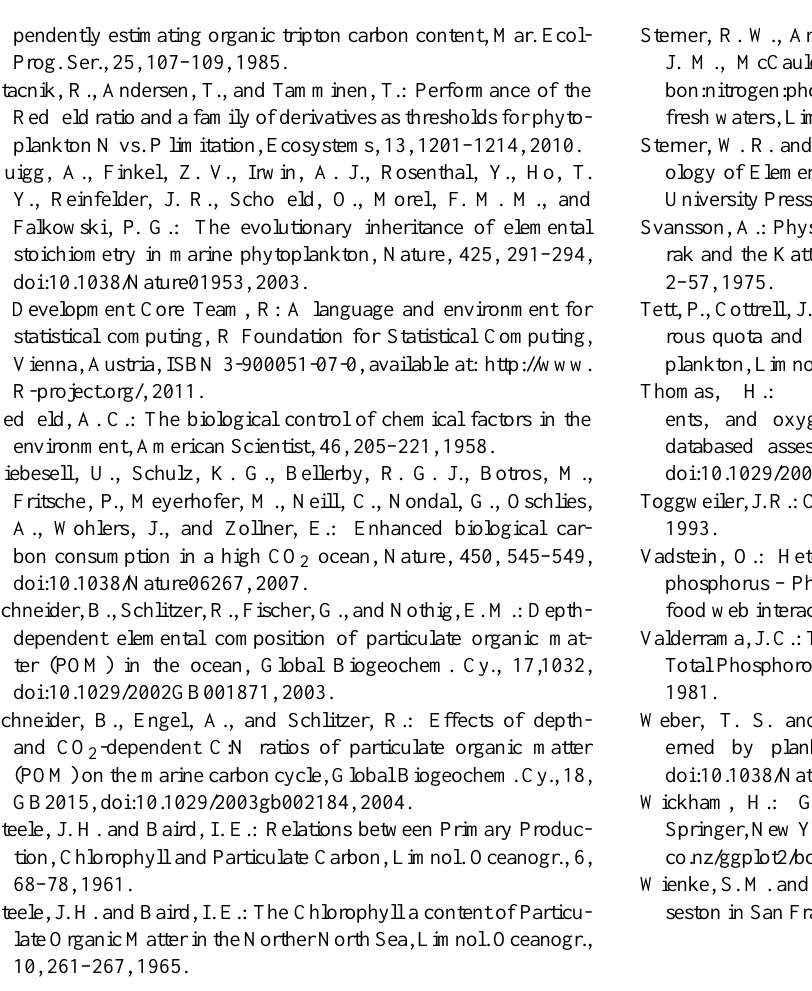
H. Frigstad et al.: Seasonal variation in marine C:N:P